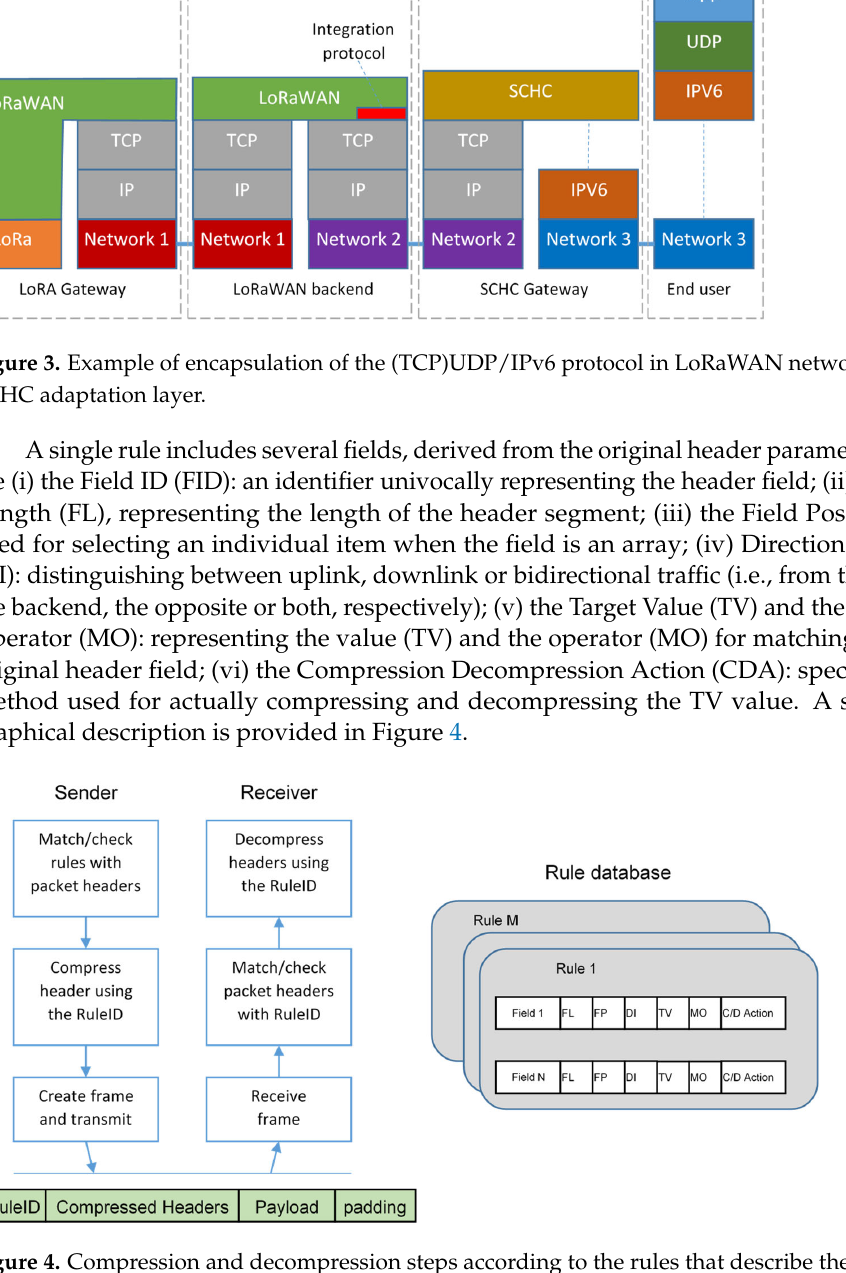
Figure 4. Compression and decompression steps according to the rules that describe the context in the SCHC approach.